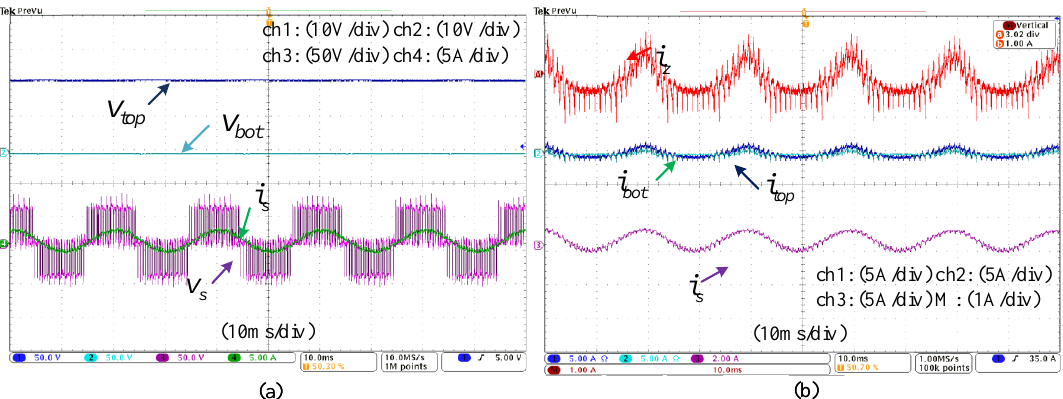
Figure 21. Experiment results with PSC3. ( a ) Phase voltage v s , phase current i s , capacitor voltage of SM v top and v bot ; ( b ) circulating current i z , phase current i s , arm current i top and i bot .